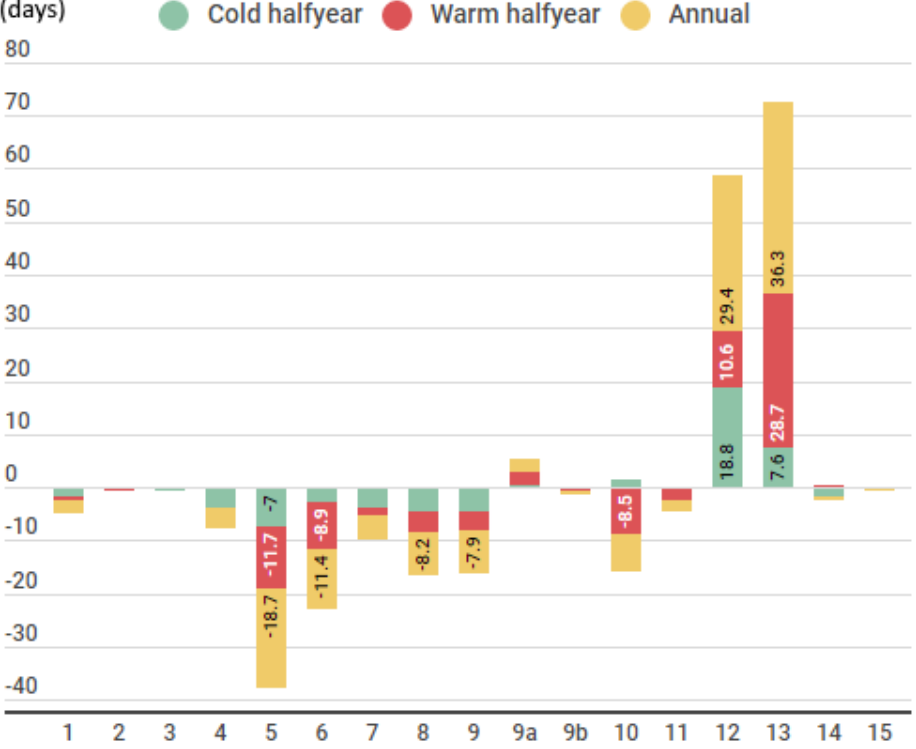
Figure 7. The di ff erence in SWT duration over Middle Asia (see Appendix A: Table A4) between the Figure 7. The difference in SWT duration over Middle Asia (see Appendix A: Table A4) between the baseline (1961–1990) and present (1991–2016) baseline (1961–1990) and present (1991–2016) periods.